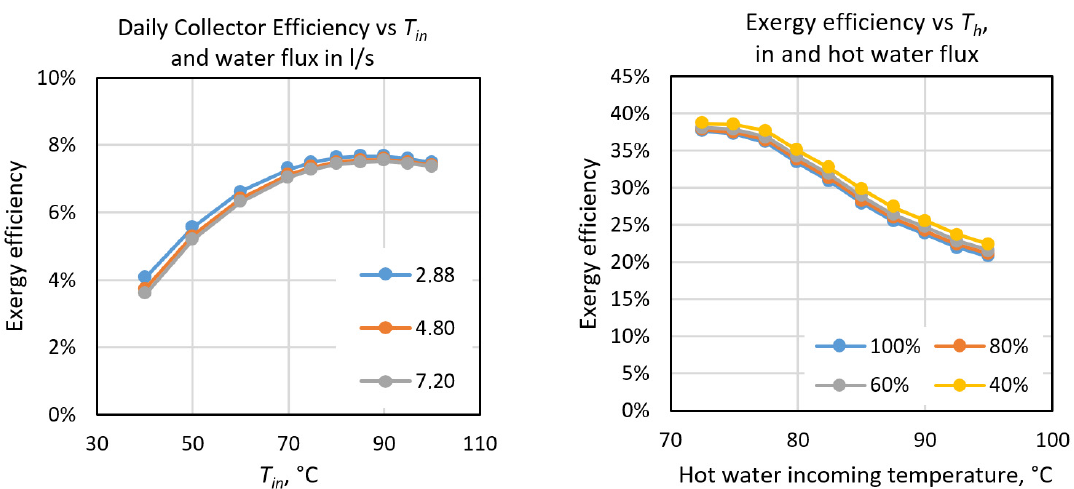
Figure 19. Exergy e ffi ciencies of solar collectors ( left ) and the absorption chiller ( right ) as a function of Figure 19. Exergy efficiencies of solar collectors (left) and the absorption chiller (right) as a function the temperature of incoming water and the flux in both of the temperature of incoming water and the flux in both systems.